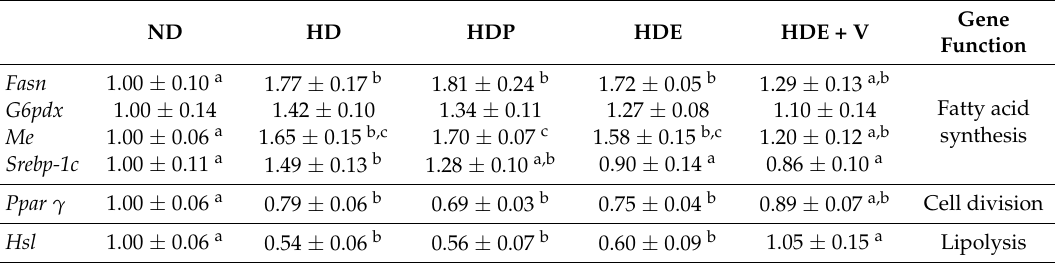
Table 4. mRNA expression level in white adipose tissue